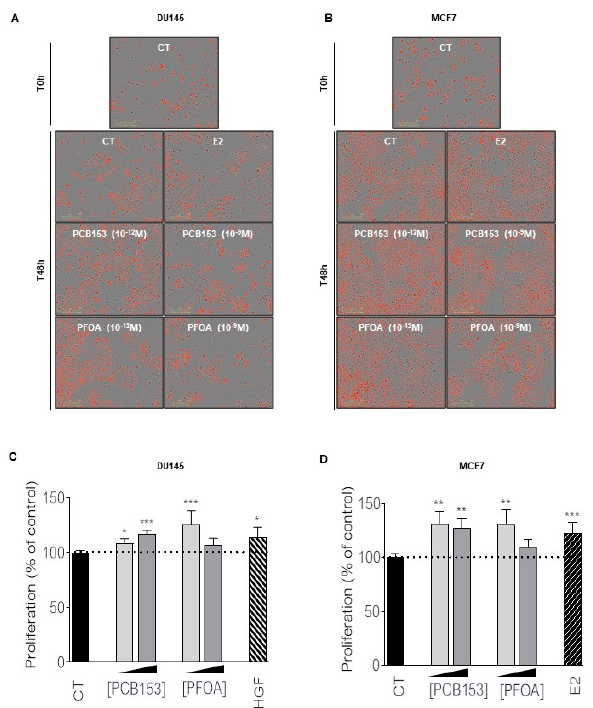
Figure 2. PCB153 and PFOA increase MCF7 and DU145 cells proliferation. ( A , B ) DU145 and MCF7 cells infected with NucLight red lentivirus representation of IncuCyte ® proliferation assay at T 0 h and T 48 h after treatment of either EtOH (CT), PCB153 (10 − 12 M or 10 − 9 M) or PFOA (10 − 12 M or 10 − 9 M). Estradiol (E2, 10 − 9 M) and HGF (10 ng/mL) were used as positive controls for MCF7 or DU145 cells, respectively. Magnification X 20 ( C , D ) BrdU cell proliferation assay. Measured proliferation of MCF7 or DU145 cells after 72 h treatment with either PCB153 (10 − 12 M or 10 − 9 M) or PFOA (10 − 12 M or 10 − 9 M) in comparison with cells treated with EtOH (CT). Estradiol (E2, 10 − 9 M) or HGF (10 ng/mL) were used as positive controls for MCF7 or DU145 cells, respectively. Each bar represents a mean ± SEM of 3 independent experiments. T test. * p < 0.05; ** p < 0.005; *** p < 0.0005.